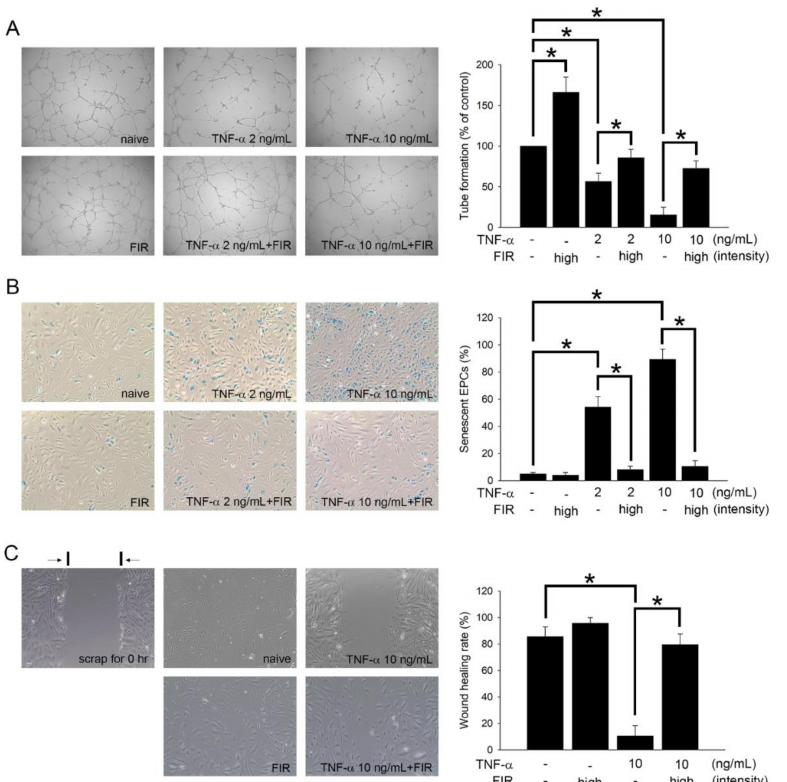
Figure 5. FIR treatment promotes the functions of human EPCs. ( A ) EPCs were stimulated with 2 or 10 ng/mL TNF- α for 24 h with or without high intensity of FIR treatment. An in vitro angiogenesis assay was used to investigate the effect of FIR therapy on EPC neovascularization. Representative photos of in vitro angiogenesis are shown. The graph shows the quantification of tube formation by TNF- α -treated EPCs following FIR treatment. ( B ) After treating EPCs with TNF- α and high intensity of FIR for 24 h, cell senescence was analyzed; the diagram shows the quantification of senescent EPCs. ( C ) A migration assay was performed to analyze the effect of FIR on TNF- α -treated EPCs. The 10 ng/mL of TNF- α were treated to EPCs, and adhered to 24 h of FIR treatment before injury scratching. Photos were taken after 8 h of injuring. Counted the migrated EPCs at the denuded location according to the black baseline under 100 × high-power field. All data are expressed as the mean ± SD of three independent experiments and as the percentage of the control. * p < 0.05 was taken into consideration statistically